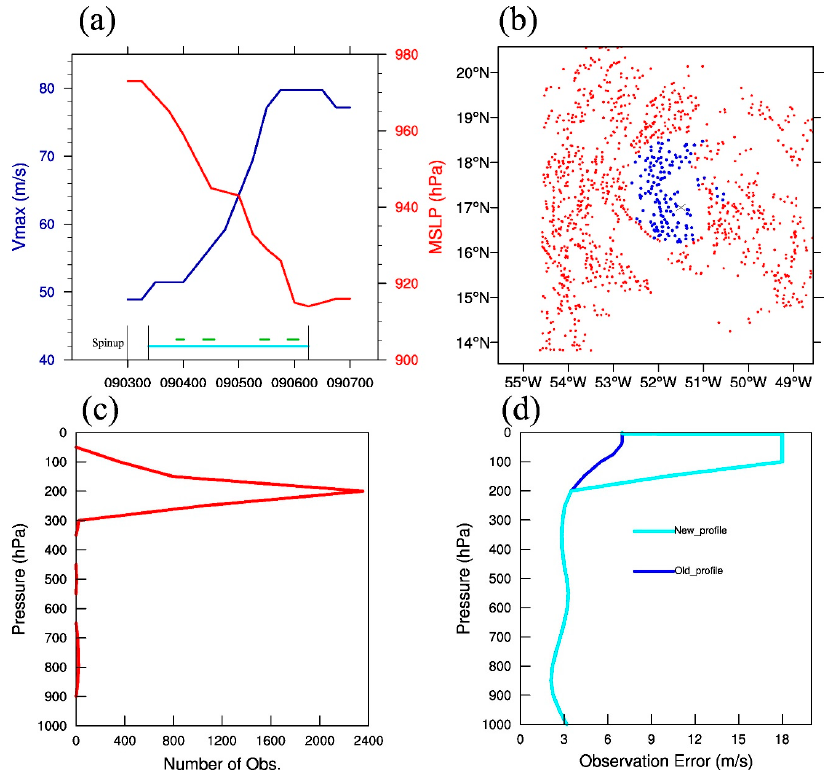
Figure 1. ( a ) Vmax (blue) and MSLP (red) evolution of hurricane Irma (2017). The availability of TDR observations and the enhanced AMVs are shown in green and cyan lines, respectively. The ( b ) horizontal and ( c ) vertical distribution of the enhanced AMVs assimilated at 06:00 UTC on 4 Sep- tember 2017. Blue dots in ( b ) are the observations above 125 hPa, and the red dots are below. The ( d ) default (blue) and updated (cyan) observation error profiles for the enhanced AMVs. Following the criteria from Velden et al. (2017) and Wu et al. (2014, 2015) [20,23,24], the enhanced AMVs are additionally preprocessed before DA. To be specific, only the observations with a quality indicator (QI) equal to or greater than 0.8 are used in this study. The quality-controlled observations are then superobbed (or averaged) within 0.055- by 0.055-degree (~6 km) boxes. Figure 1b shows an example of the horizontal dis- tribution of the preprocessed AMV observations valid at 06:00 UTC on 4 September 2017. By default, the AMVs above the 125 hPa will be discarded by GSI. The observations that are above 125 hPa can be considered as from the inner-core regions (with deep convection) and are marked in blue dots. The vertical distribution of the same preprocessed AMVs from the innermost domain (2 km) is shown in Figure 1c. It clearly shows that the en- hanced observations for this innermost domain peaked at around 200 hPa. The vertical profile of the default observation error profile used by the operational HWRF is shown in Figure 1d along with the modified error profile. The major difference is the enlarged ob- servation errors in the upper levels above 200 hPa (Chris Velden, personal communica- tion, 2020). Such an increase in the upper levels is due to having more observations to